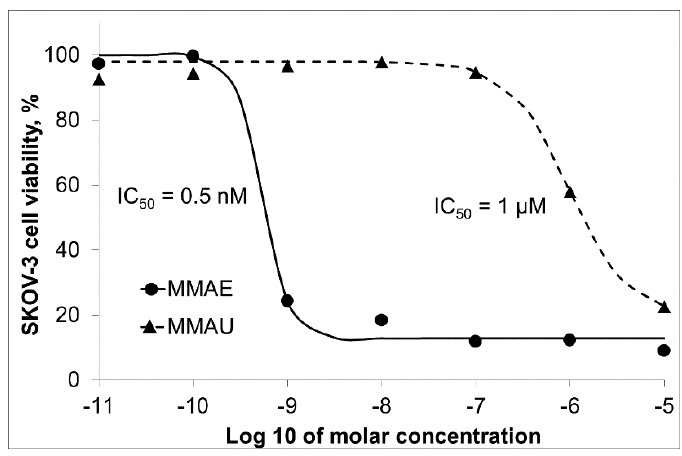
Figure 4. Cytotoxicity assays reveal that the hydrophobic payload MMAE is 2000-fold more cytotoxic against SKOV-3 ovarian cancer cells than MMAU.